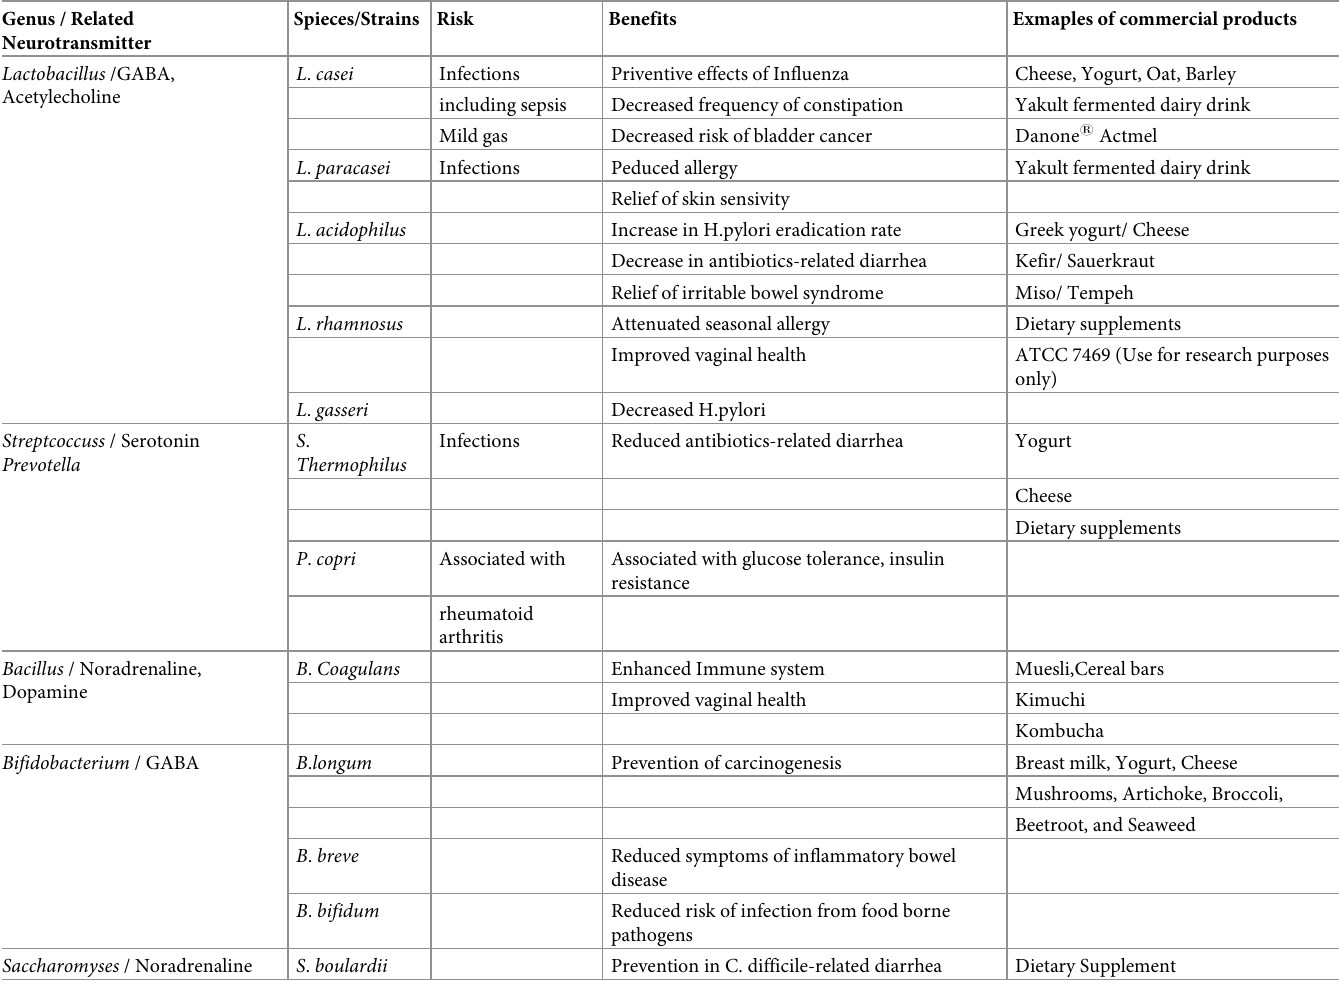
Table 4. Summary of risks, benefits, and examples of commercial products for major microbial genes. Genus / Related